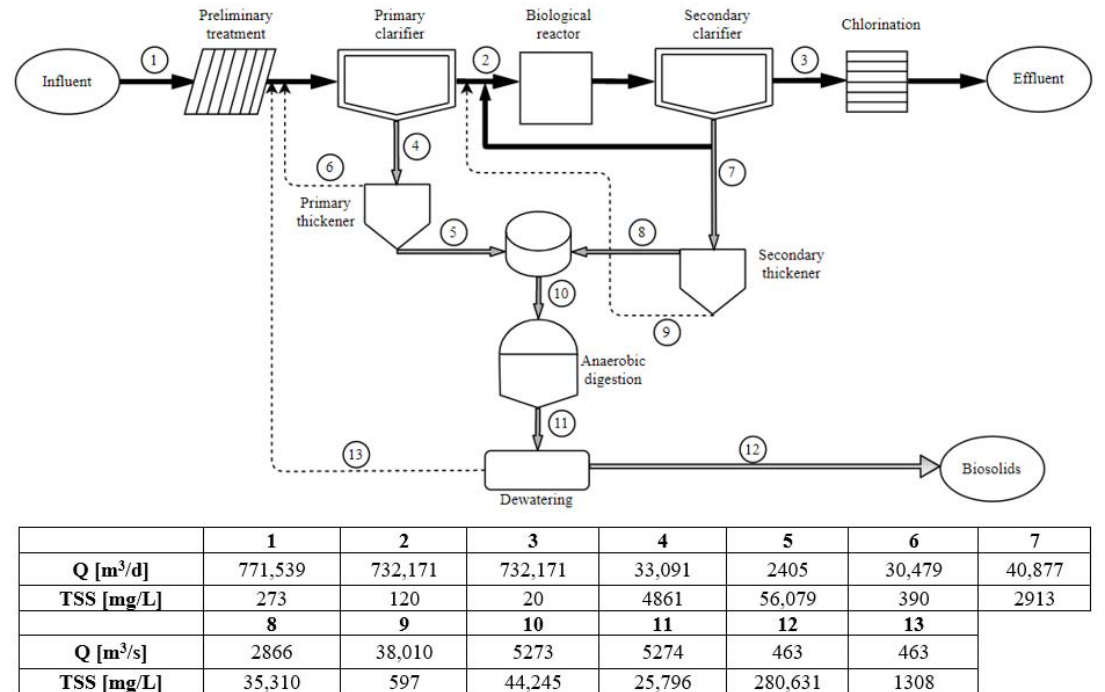
Figure 1. Schematic of the model WWTP. Data correspond to flow rates (Q) and total suspended solids (TSS) concentration between treatment stages. The black arrows represent the water line (wastewater treatment units), the gray arrows represent the sludge line (sludge treatment units), and the dashed arrows represent return flows.